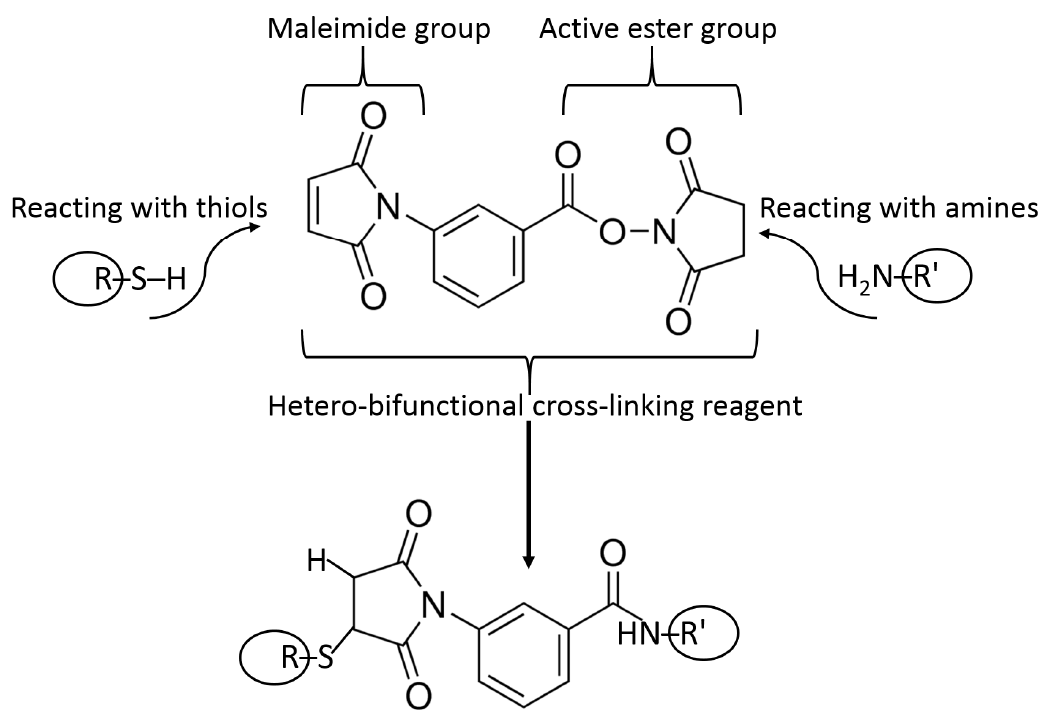
Figure 11. A heterobifunctional cross-linker containing a maleimide function for binding to thiol groups of biomolecules and an active ester function for binding to amino groups of biomolecules. Note the short and rigid spacer between the reacting groups. Many other similar cross-linkers are available with various structures and lengths of the spacer connecting the reacting groups.